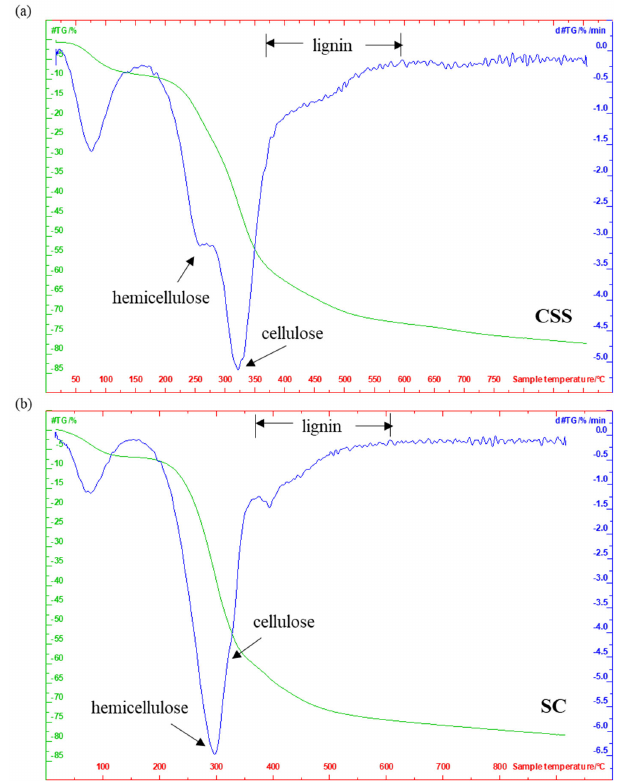
Figure 3. TG and DTG results of coffee residues: ( a ) CSS; ( b ) SC. Table 3. TG-MS with an indication of m / z signals, possible assignment, and